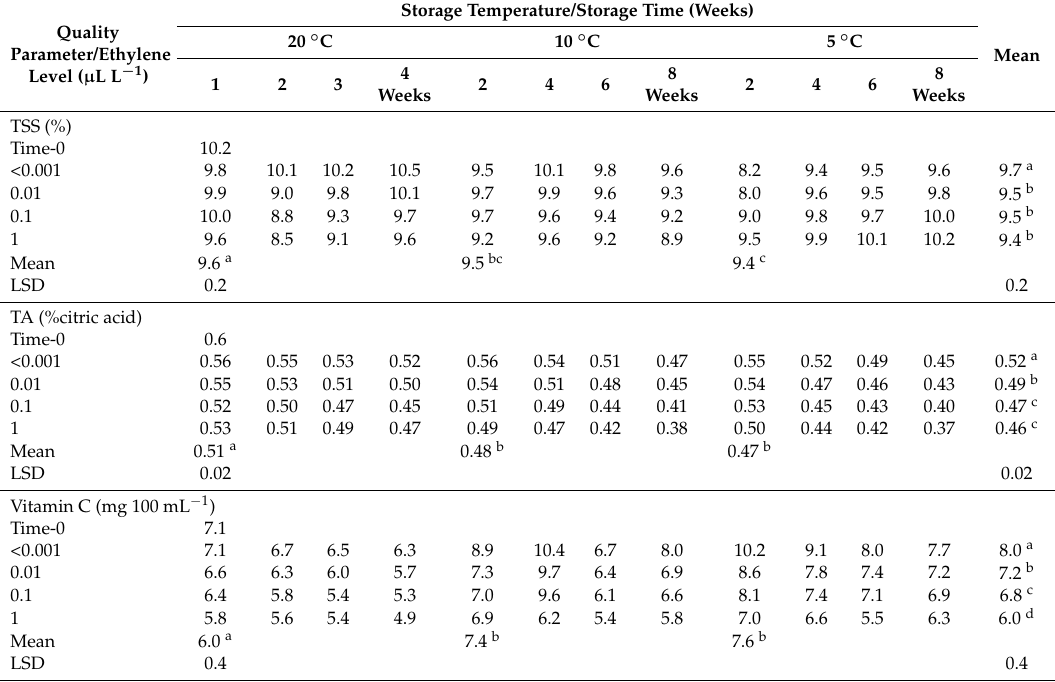
Table 6. TSS, titratable acidity (TA) and vitamin C content of ‘Afourer’ mandarins during storage at 20, 10 and 5 ◦